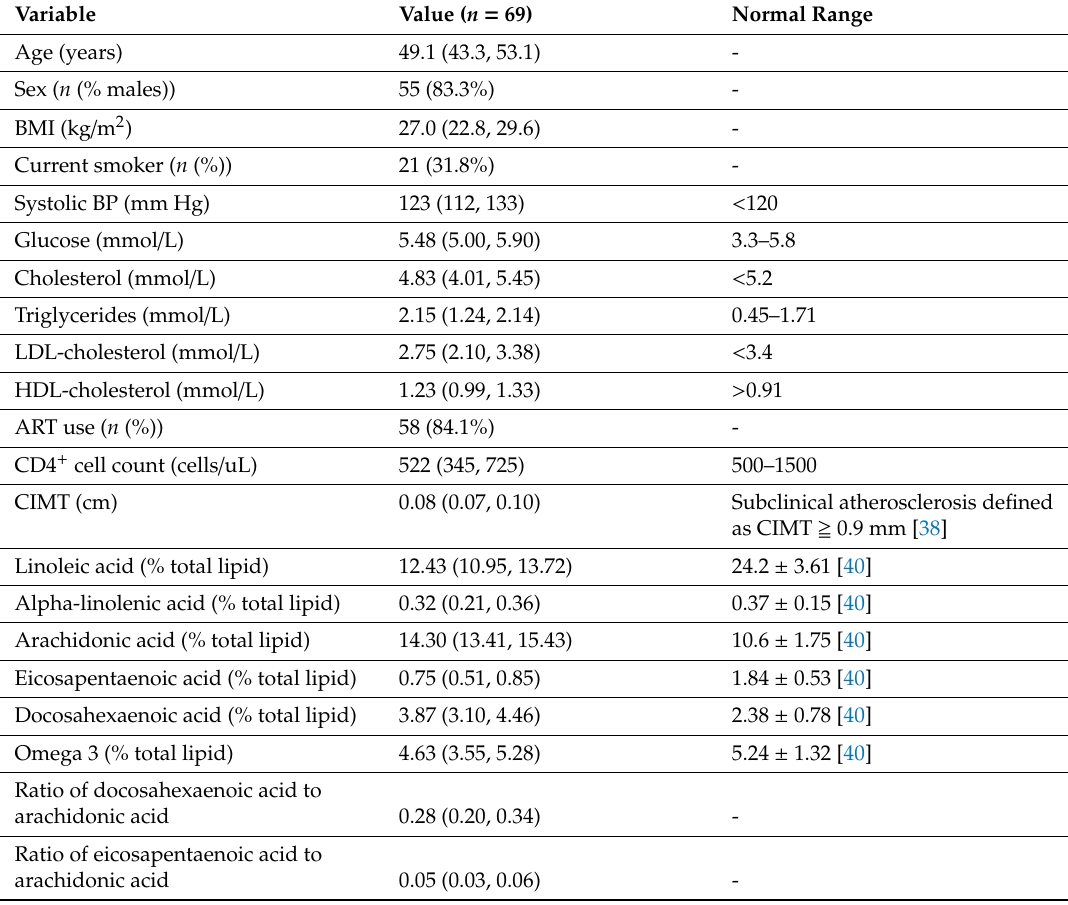
Table 5. Demographic and clinical characteristics of polyunsaturated fatty acids (PUFA) cohort. Variable Value ( n = 69) Normal